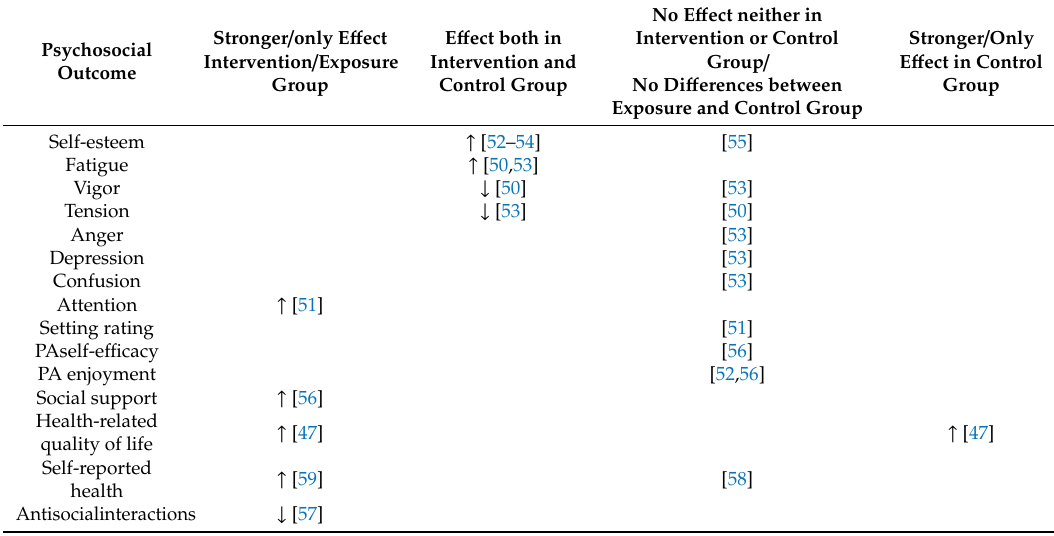
Table 3. E ff ectiveness and psychosocial outcomes of green exercise (GE).